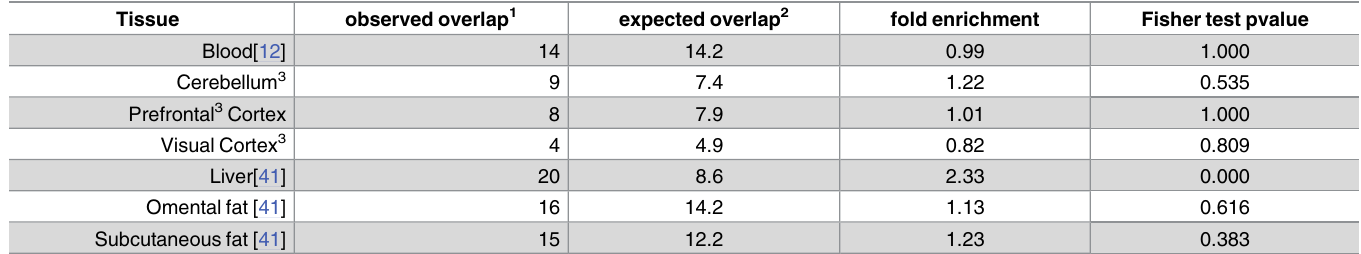
Table 3. Overlaps between blood serum protein-QTLs and previously published eQTLs from severaltissues (10% FDR).